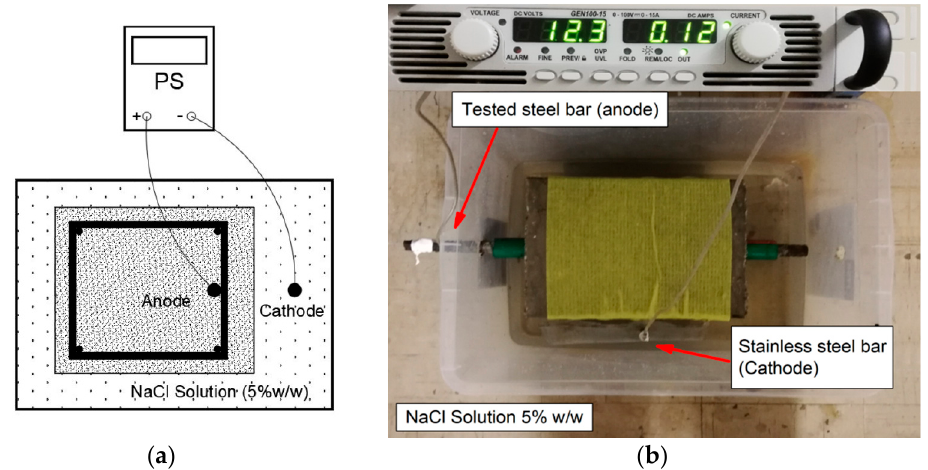
Figure 3. ( a ) Schematic illustration of the accelerated corrosion technique. ( b ) Accelerated corrosion test of the RC specimen.